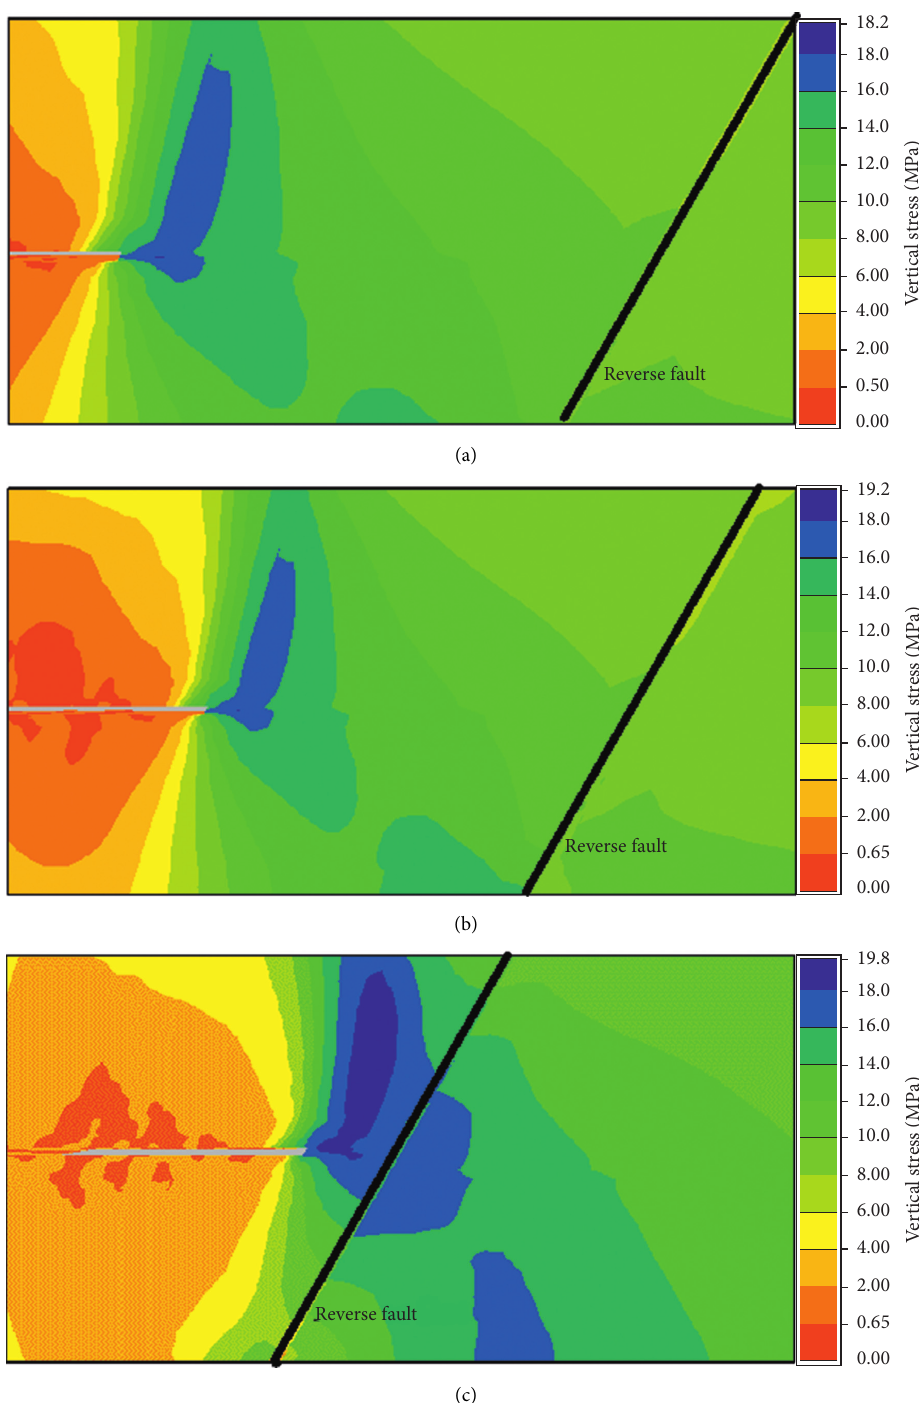
Figure 4: Variation of hanging-wall mining-inflicted stress on the coal body under different distance between working face and reverse fault. (a) The working face is 70m away from the reverse fault. (b) The working face is 40m away from the reverse fault. (c) The working face is 10m away from the reverse